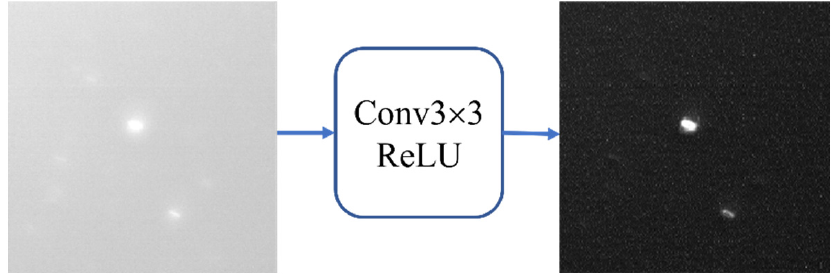
Figure 5. Changes in the image before and after the convolution operation.